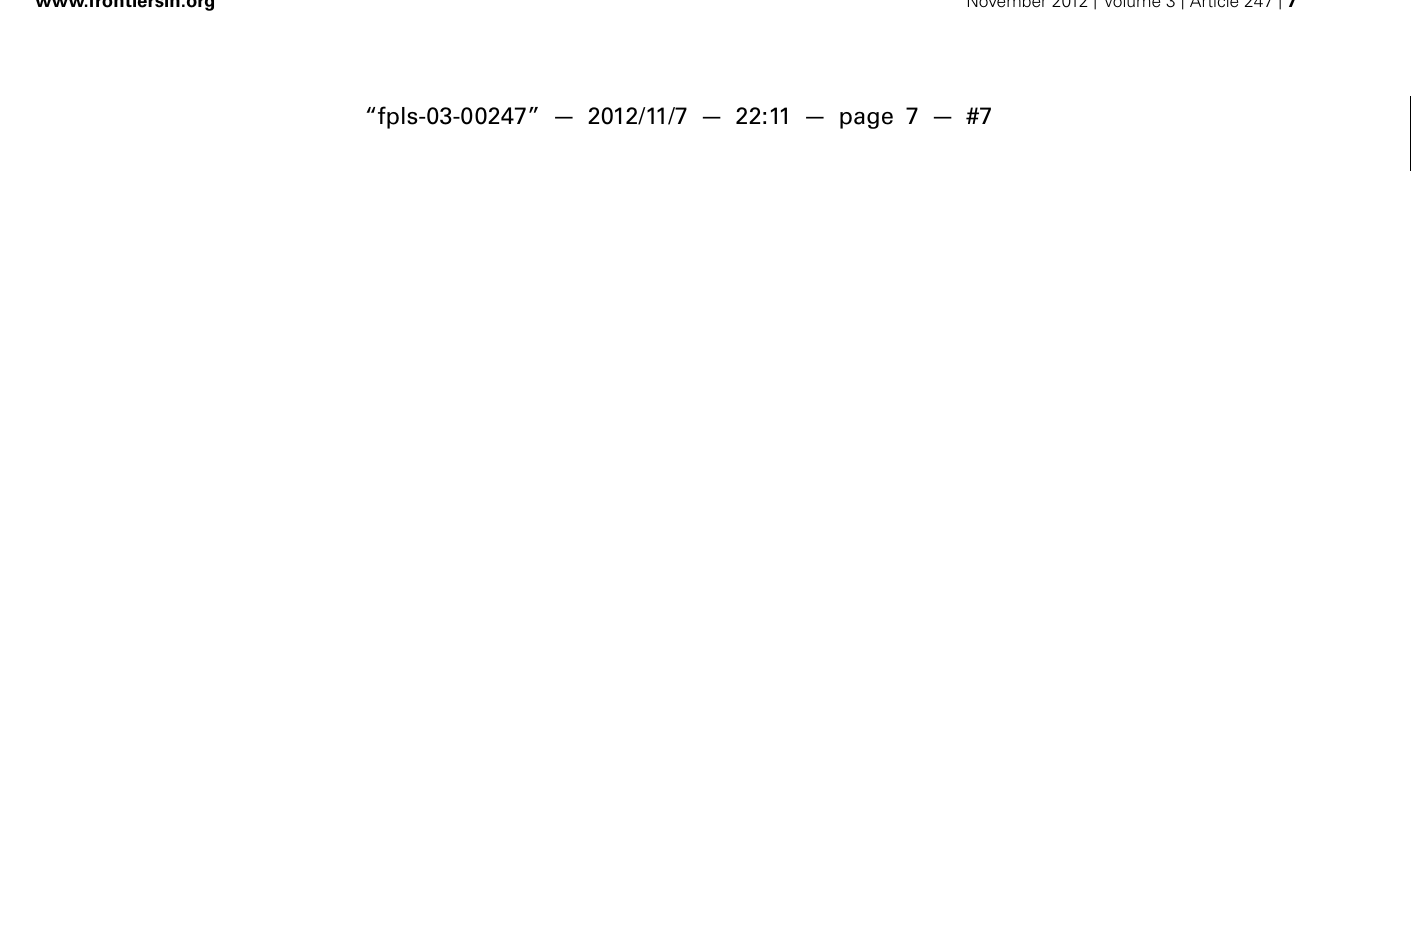
FIGURE 4 | Subcellular localization ofANAC089 in A. thaliana protoplasts. (A) Protoplast in bright field. Fluorescence image of a protoplast expressing the C-terminally CFP-tagged ANAC089 (B) or the C-terminallyYFP-tagged ANAC089 (C) . Comparative localization of ANAC089 und ABI5 with C-terminally fused fluorophores in A. thaliana protoplasts. (D) Bright field control picture. (E) ANAC089-CFP-signal detected in vesicles, endoplasmic reticulum, and plasmamembrane.